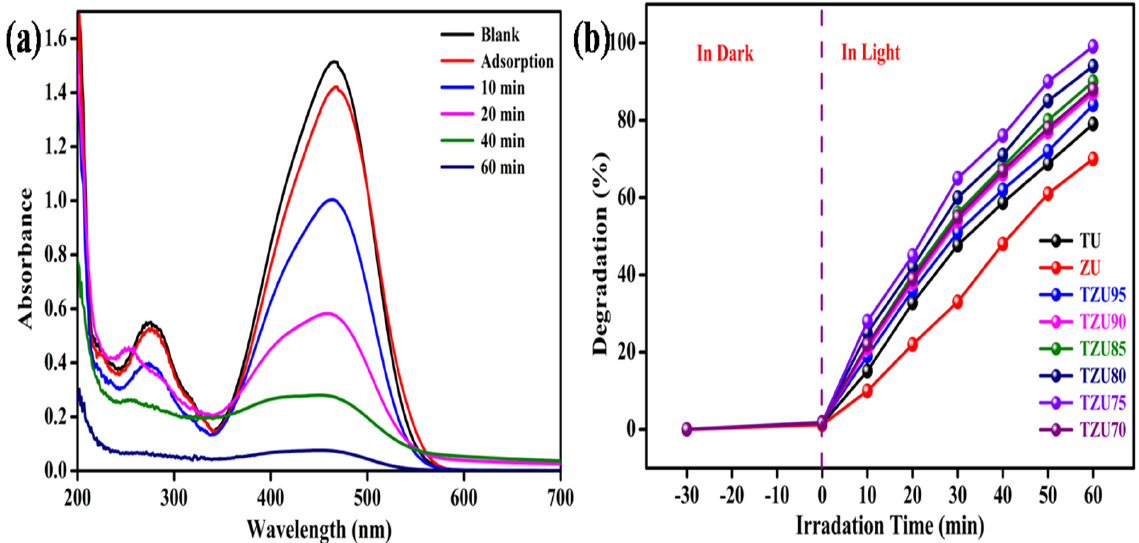
Figure 6. Photocatalytic activity of MO solution over TZU75 under UV light irradiation: ( a ) absorbance against wavelength; ( b ) degradation against irradiation time.